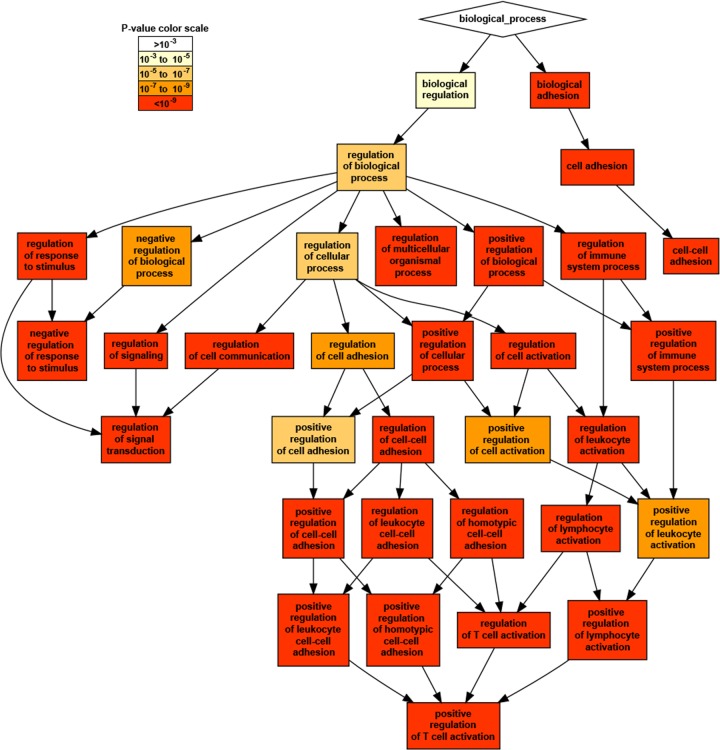
GO-term enrichments for GICs.Directed acyclic graph created by GOrilla using Graphviz, displaying the most significantly enriched GO-process annotations for the annotated genes near GICs.